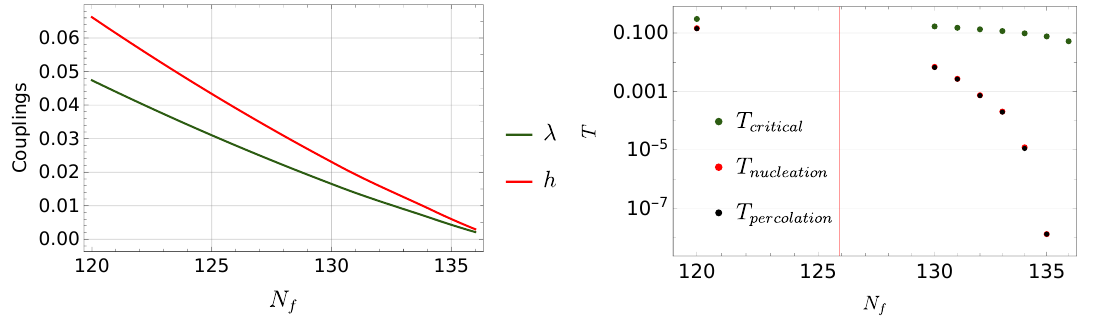
Figure 3 . We represent, on the left, the values of the coupling (cid:21) and h at the scale of symmetry breaking as a function of the number of fermions and, on the right, the values of the critical temperature, nucleation temperature and percolation temperature as a function of the number of fermions. The red line denotes the approximate number of fermions for which we expect the loop series expansion to